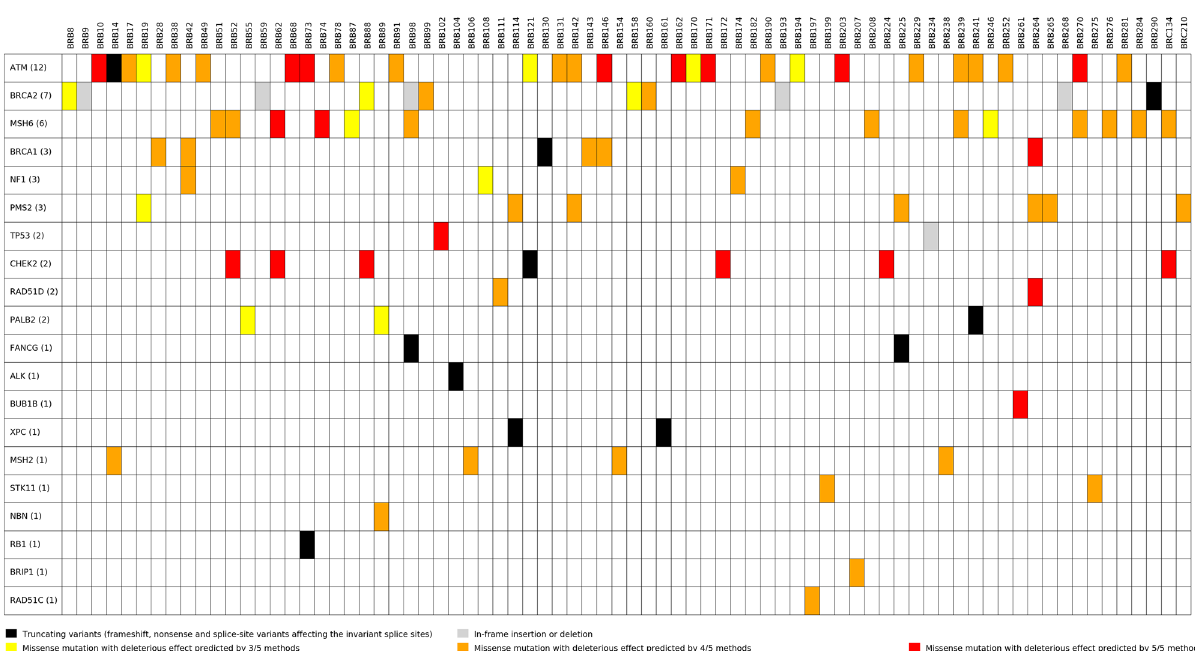
Figure 2. Matrix of patients vs. genes with sequence variants in breast cancer susceptibility genes and genes exclusively investigated for truncating variants (multiple variants per gene may be present). The genes are sorted from the most to least number of variants per gene as indicated in brackets. Black indicates truncating variants (frameshift, nonsense and splice-site variants affecting the invariant splice sites); Grey indicates an in-frame insertion or deletion. Missense variants are indicated according to the five in silico functional effect predictors, where yellow indicates a deleterious effect predicted by 3/5 methods, orange 4/5 methods and red 5/5 methods (Figure generated using Matplotlib 3.4.2: https:// matpl otlib.